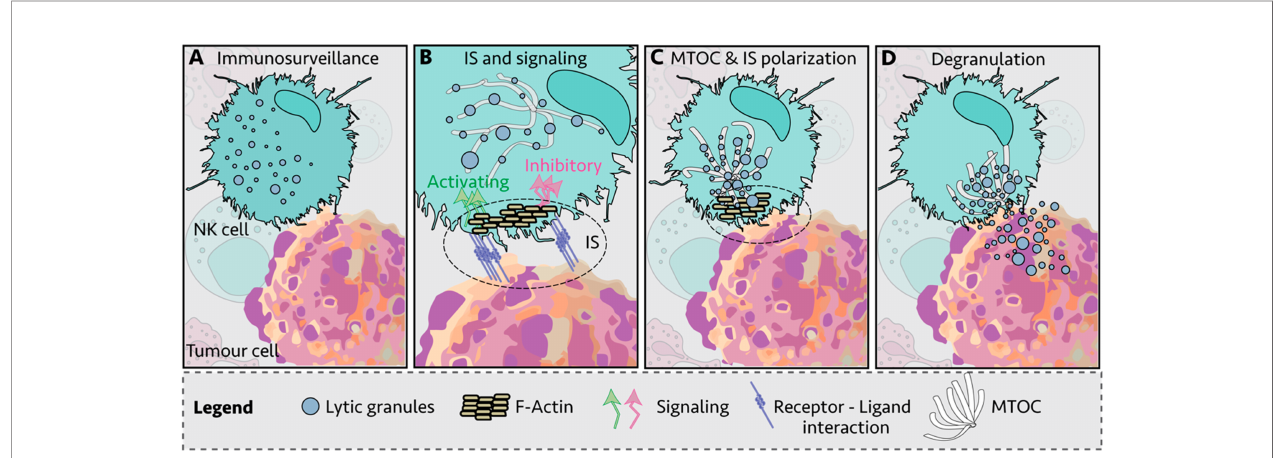
FIGURE 2 | Immunological synapse (IS) of Natural Killer (NK) cell and target cell. (A) NK cells engage other cells to create an immunological synapse (IS); (B) First, fi lamentous actin (F-actin) is recruited to the IS; (C) NK lytic granules move along microtubules by dynein – dynactin motor proteins toward the microtubule-organizing center (MTOC); (D) the polarized lytic granules and MTOC dock at the IS, and degranulate